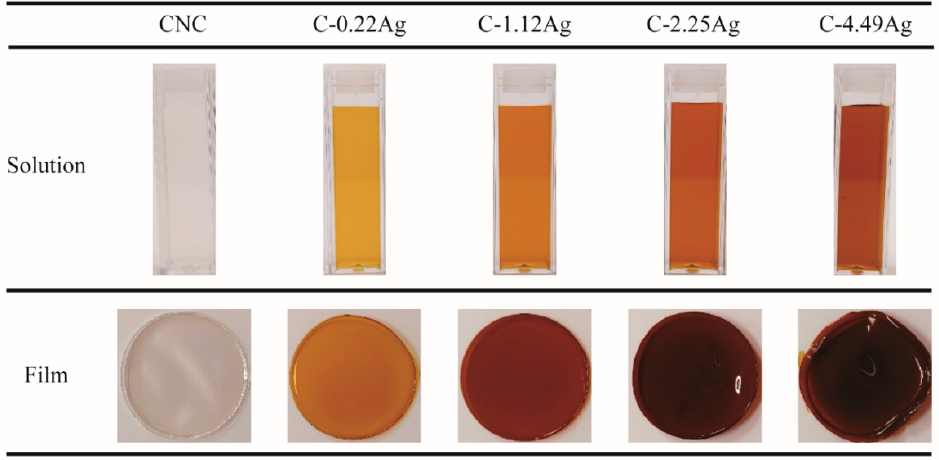
Figure 1. Photographs of CNC and CNC-AgNP composite samples.